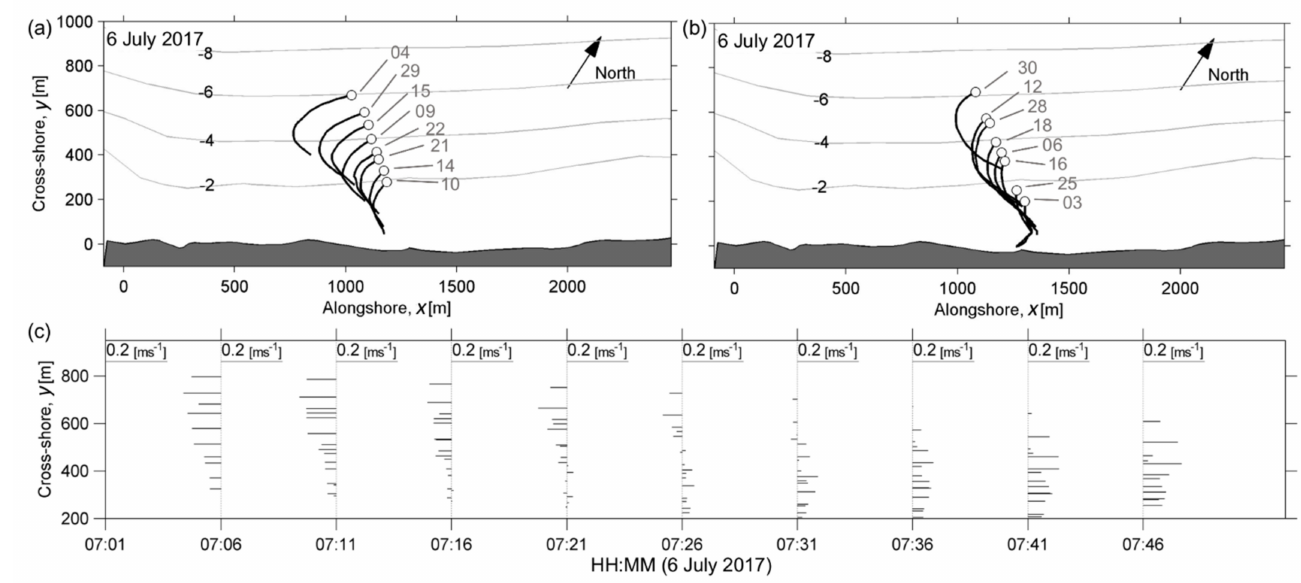
Figure 4. Case I experiment. ( a,b ) Trajectories of drifter clusters. The contour indicates the water depth (m). The areas of ( a,b ) are also shown as the black rectangle in Figure 2b. The x-axis represents the alongshore direction; the y-axis represents the cross-shore direction in the UTM coordinate system after rotating 33 degrees clockwise. The circles are the initial positions of drifters; the solid black lines connected to them are the trajectories. The drifter IDs are shown near the released points. ( c ) Alongshore velocity component measured by the sea-surface drifter clusters as a function of cross-shore distance versus time during the current